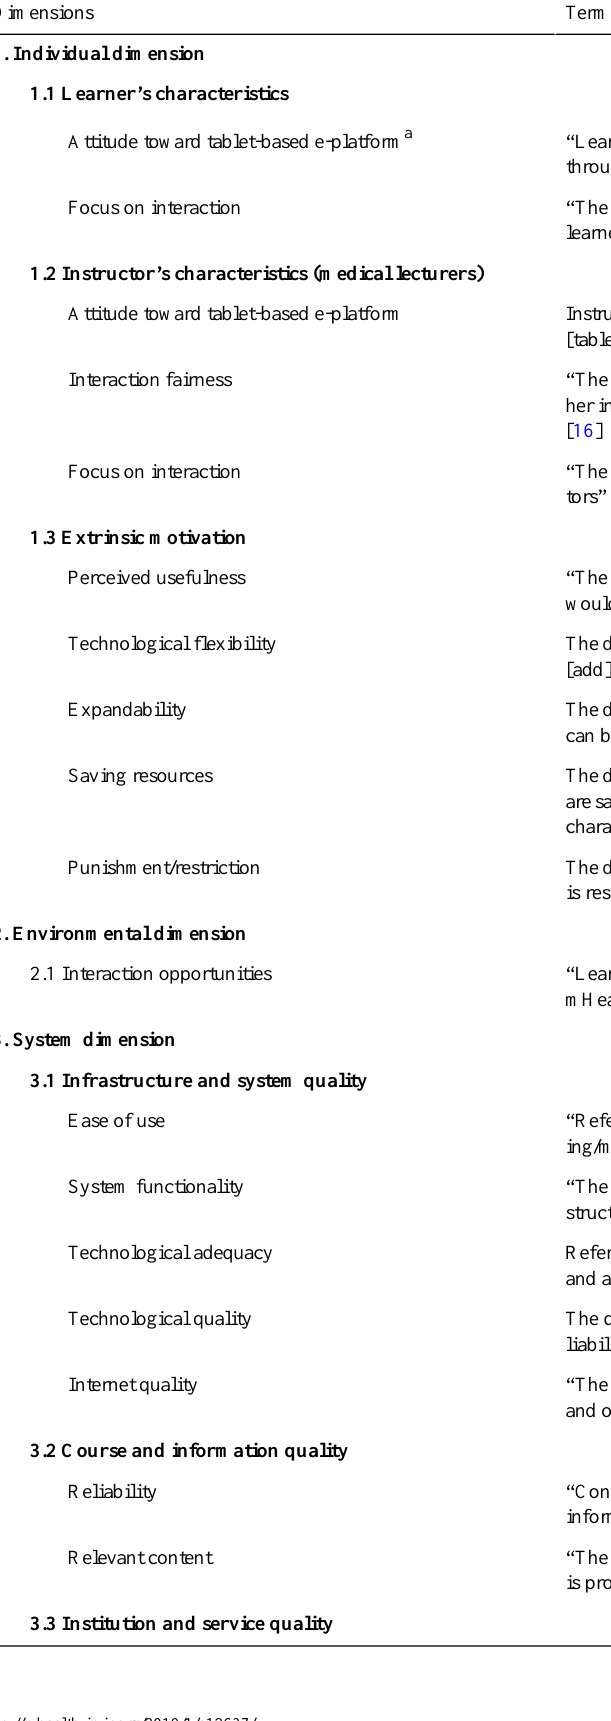
Table 1. Bhuasiri et al’s research framework [16] for successful technology-supported learning (e-learning) implementation, with our additions for the tablet-based e-platform (marked with [add] in the table). The research framework has 3 major themes (individual dimension, environmental dimension, and system dimension) that unfold into